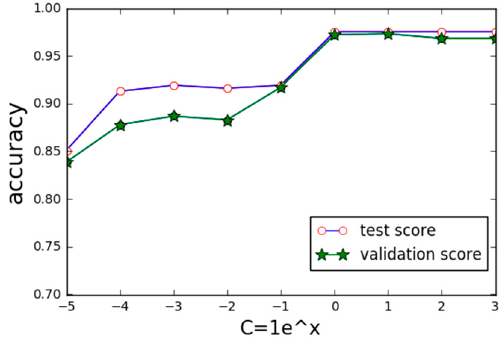
Figure 10. Selection of penalty factor C in multiple classification.